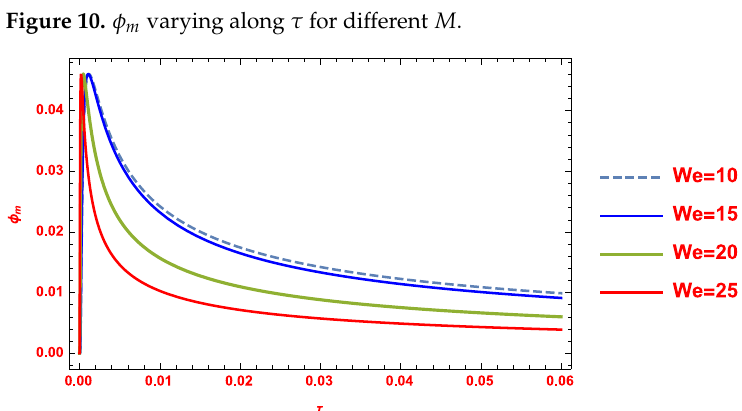
Figure 10. φ m varying along τ for different M .